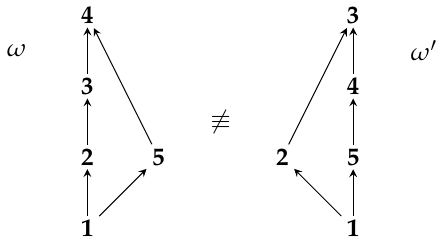
Figure 8. Two non-torically equivalent orientations ω (cid:54)≡ ω (cid:48) in Acyc ( C 5 ) for which P ( C 5 , [ ω ]) and P ( C 5 , [ ω (cid:48) ]) have the same set of toric